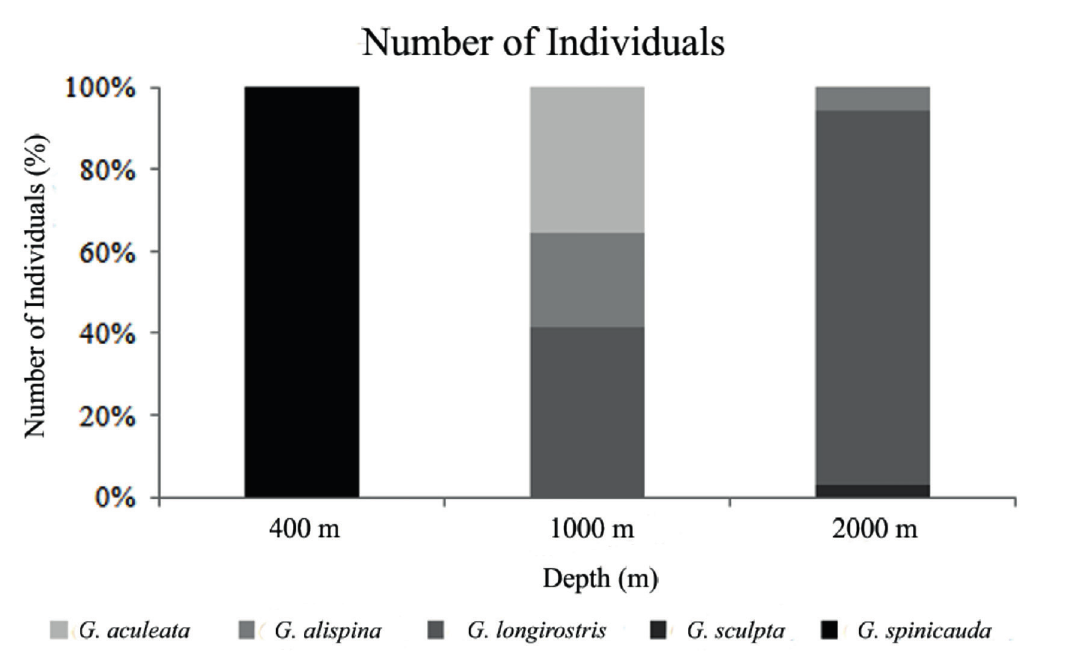
Figure 7. Number of specimens of Glyphocrangon A. Milne-Edwards, 1881 based on the depth in Potiguar Basin, northeastern